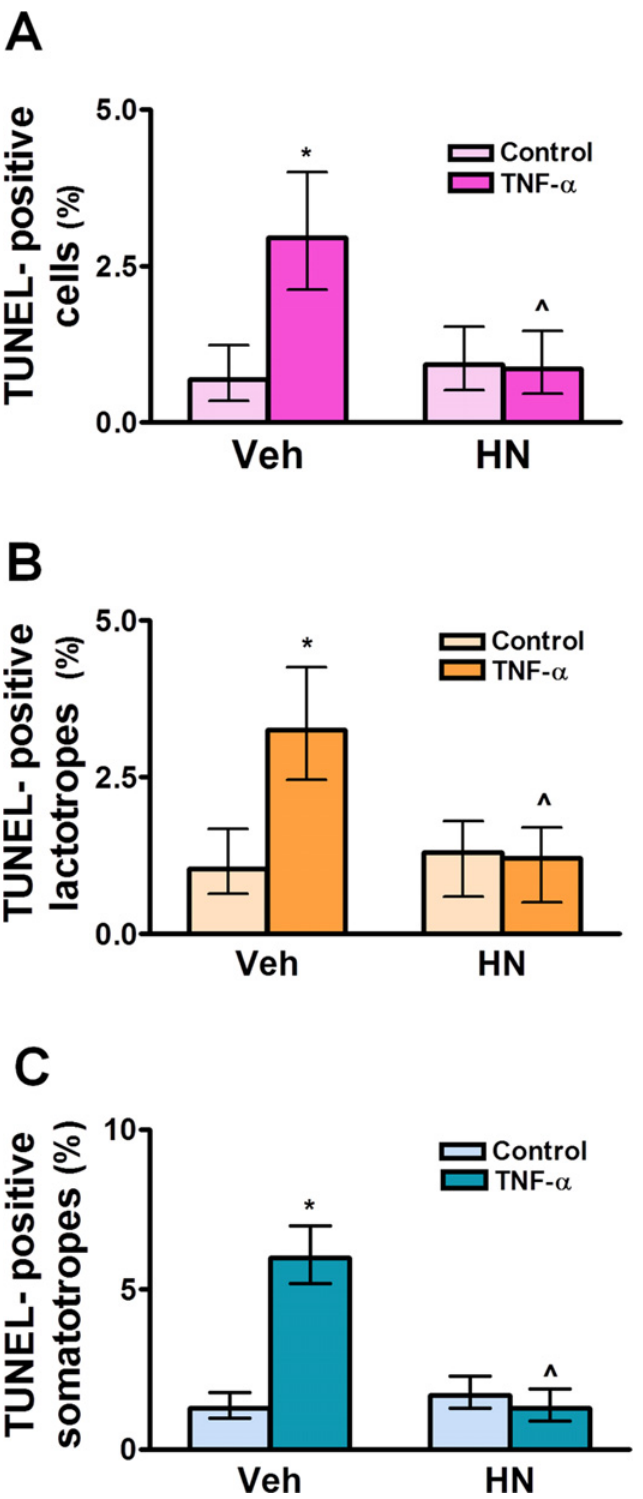
Fig 7. HN protects anterior pituitary cells from TNF- α -induced apoptosis in male rats. Cultured anterior pituitary cells from GNX male rats were incubated with dihydrotestosterone (DHT, 10 -8 M) for 24 h and then with HN (0.5 μ M) for 2 h before adding TNF- α (50 ng/ml) for an additional 24 h. Apoptosis was assessed by